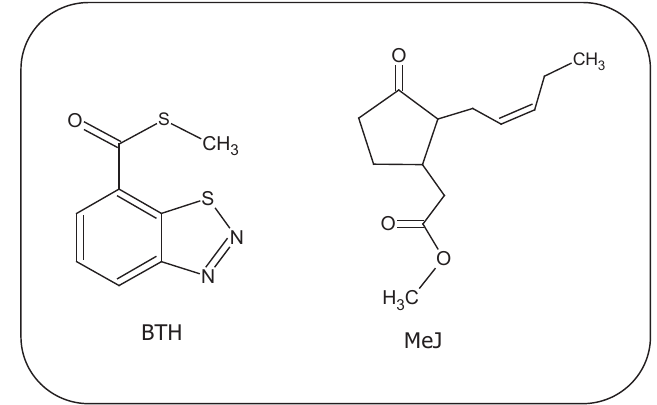
Figure 2 . Chemical structures of the elicitors, benzothiadiazole and methyl